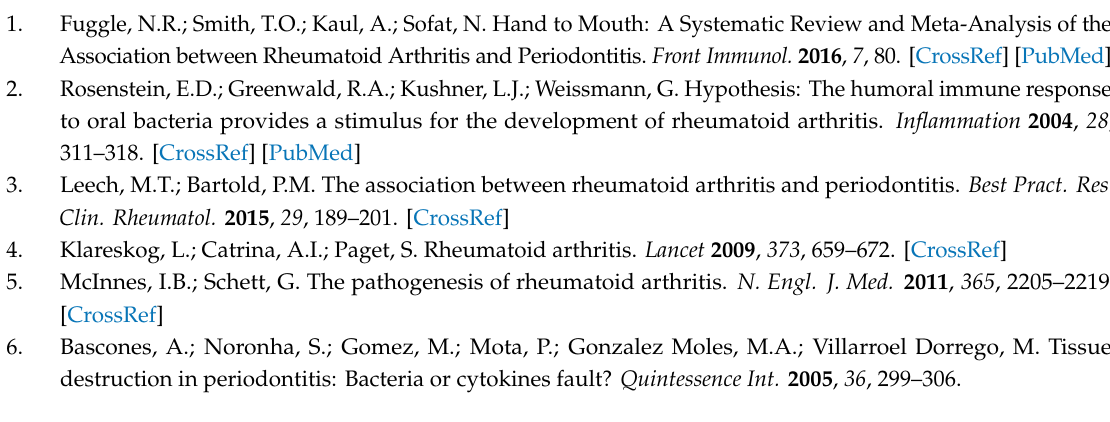
Table S1: Periodontal and dental characteristics in relation to periodontal diagnosis, Table S2: Characteristics of subjects with RA in relation to the ACPA status, Table S3: Most abundant bacteria in saliva of patients with RA in relation to the periodontal diagnosis, Table S4. Presence of subgingival P. gingivalis in relation to the periodontal diagnosis. Supplementary